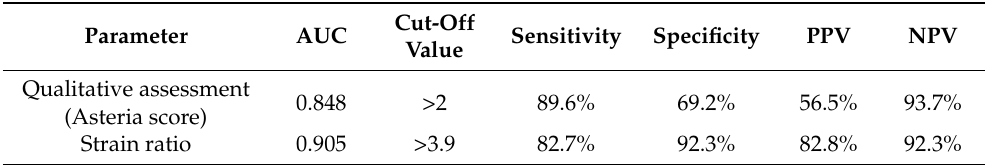
Figure 4. Risk upgrade from intermediate risk in B-mode to high risk in B-mode + SWE due to increased stiffness (Mean EI = 68.2 kPa). Pathology report confirmed PTC. Table 5. The diagnostic performance of SE parameters: Asteria score and strain ratio for the presence of thyroid malignancy, using the pathology report as